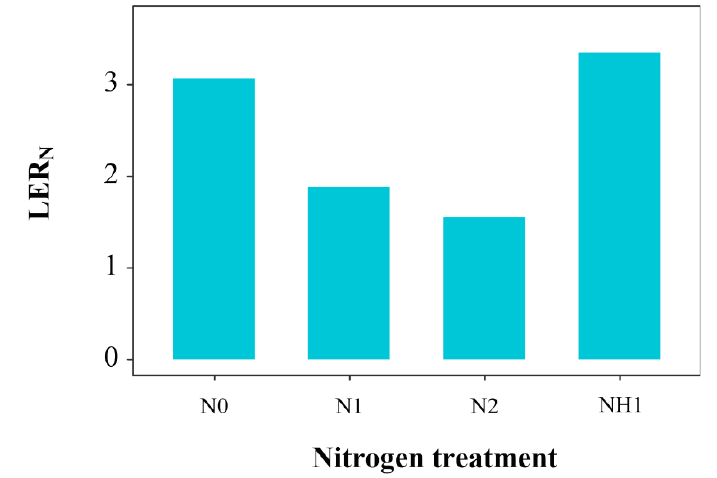
Figure 4. Variations in LERN values under the different N treatments.